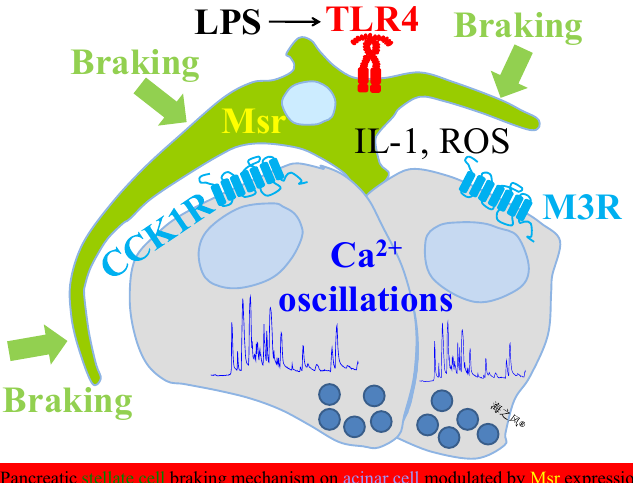
Figure 8. Rat pancreatic stellate cells serve as a brake mechanism on pancreatic acinar cell calcium signaling modulated by Msr expression. Activation of pancreatic acinar cell cholecystokinin 1 (CCK1) or muscarinic 3 (M3) acetylcholine receptors triggers cytosolic calcium oscillations, which can be blocked by the surrounding activated pancreatic stellate cells. LPS stimulation of rat pancreatic stellate cell surface TLR4 triggers reactive oxygen species generation and IL-1 production, leading to the activated state of pancreatic stellate cells. Pancreatic stellate cell activation is inhibited by the over-expression of Msr to decelerate the braking mechanism. Note that both IL-1 and reactive oxygen species (ROS) could readily diffuse from stellate to acinar